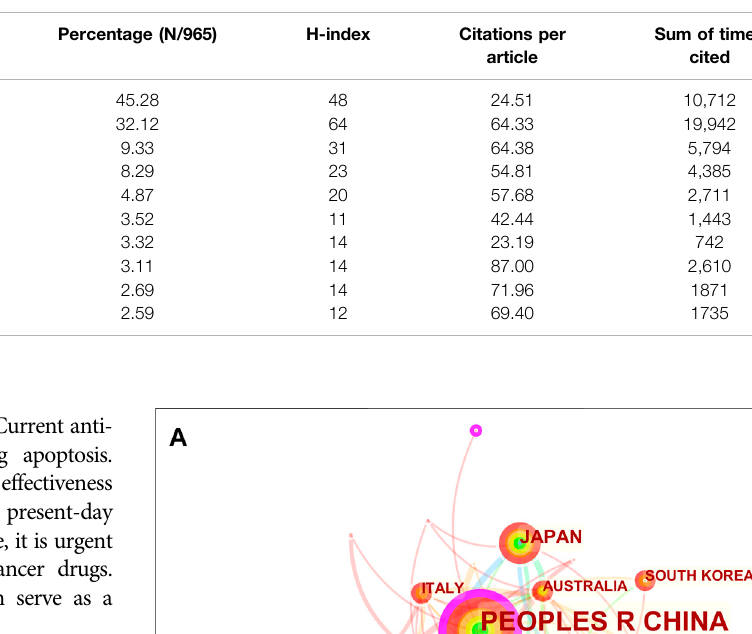
Frontiers in Cell and Developmental Biology |